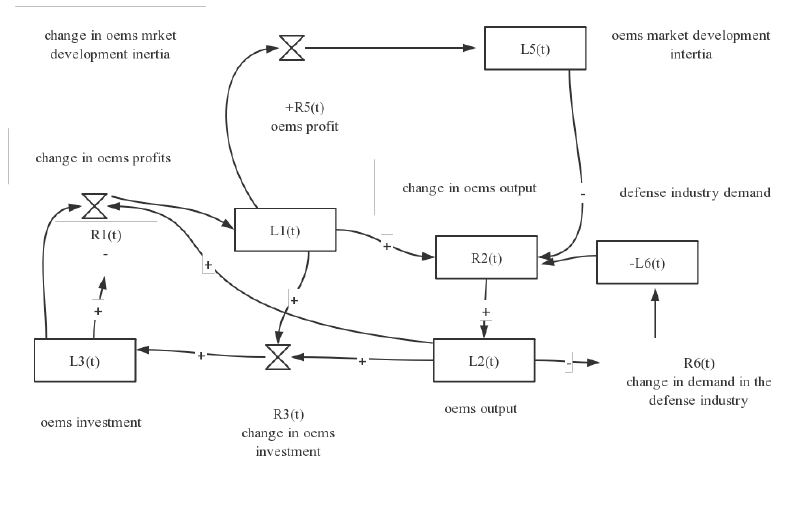
Fig. 3 Component supplier performance schema.